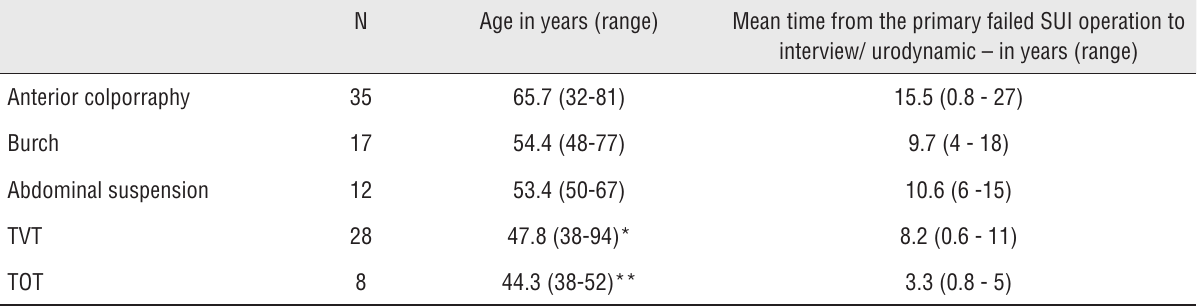
Table 1 - Demographic characteristics of 100 failed patients surgically treated for